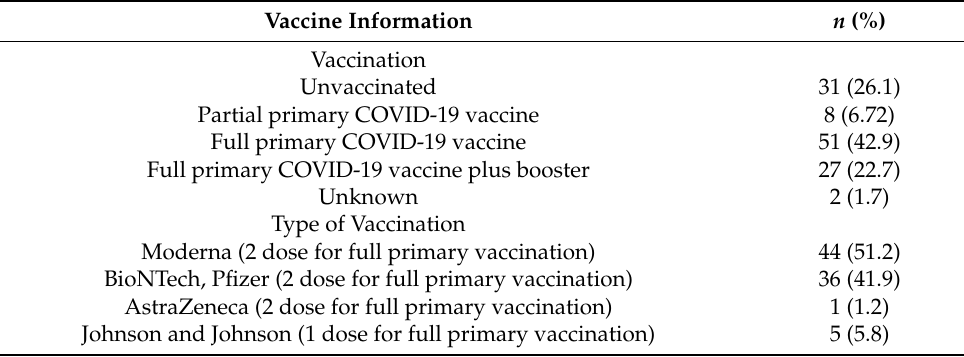
Table 2. Vaccination information for the complete cohort ( n = 119).